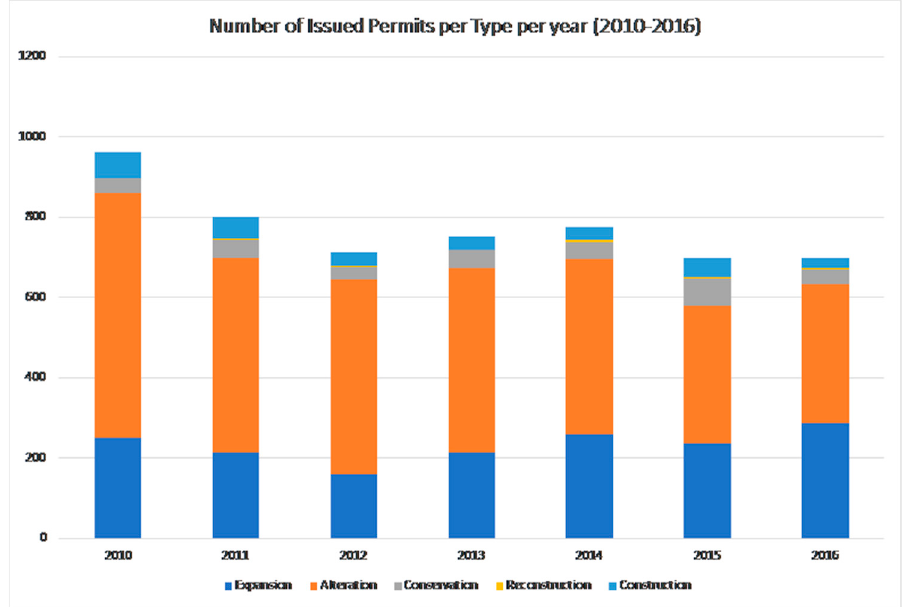
Figure 10 . Number of Issued Permits per type per year in the filtered set. Source: Authors, based on Lisbon city building permit database.